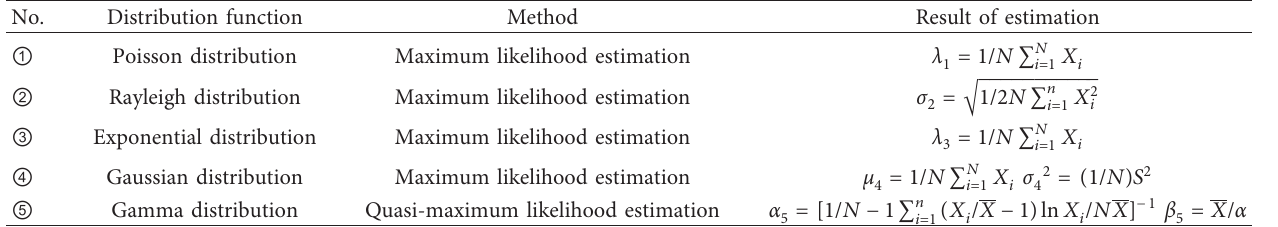
Table 1: The results of estimation for parameters.